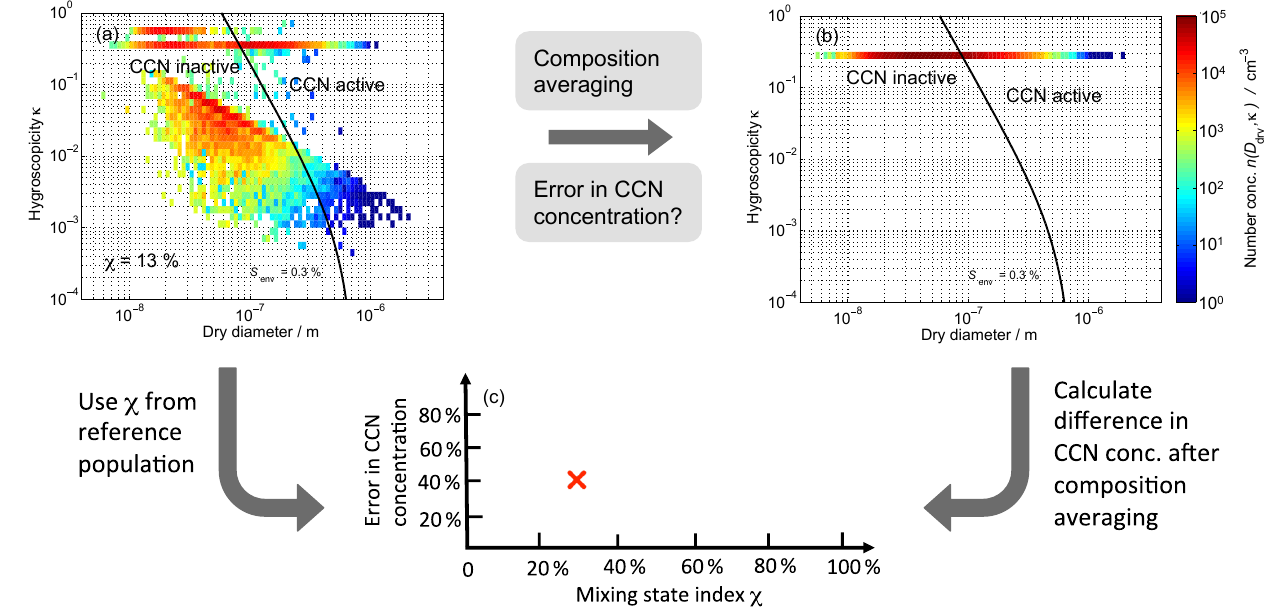
Figure 4. Conceptual framework for error quantification; see Sect. 4 for details.